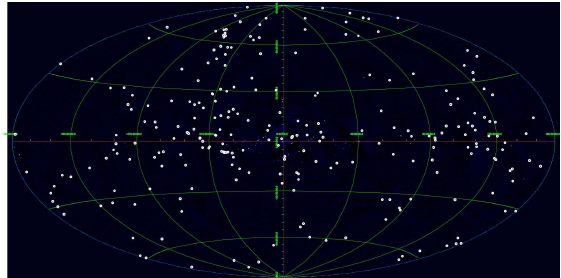
Figure 4: Distribution of AGNs (white filled circles) in the 20-100 keV sky imaged by IBIS. This is an IBIS 20-100 keV image.